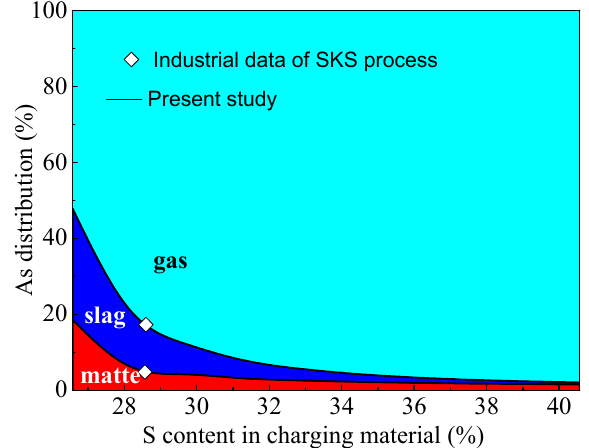
Figure 3. Comparison between the actual production and simulation results of the effect of S content in concentrate on the distribution of arsenic among the gas, slag and matte.